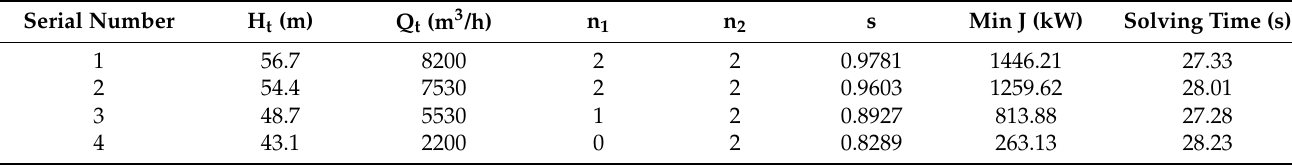
Table 1. Part of the results from the improved DE algorithm optimization Table 2. Part of the results from the GA optimization process.